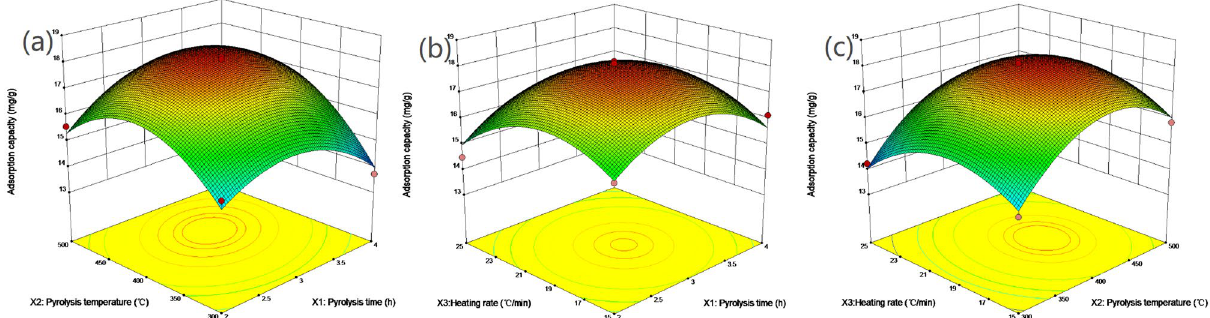
Figure 3. Three-dimensional (3D) plot of Cu 2+ adsorption capacity: ( a ) influence of pyrolysis time VS pyrolysis temperature, ( b ) influence of pyrolysis time VS heating rate, and ( c ) influence of pyrolysis temperature VS heating rate (Generated by Design-Expert 10.0, Stat-Ease. Inc., Minneapoils, MN, USA, https:// www. state ase. com/).